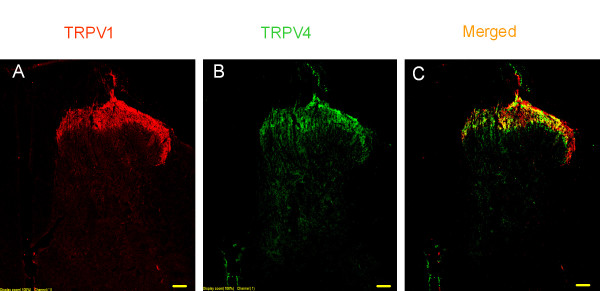
TRPV1 and TRPV4 are expressed at the central terminals and are co-localized in spinal dorsal horn. A. Immunostaining of TRPV1 in dorsal horn. B. Immunostaining of TRPV4 in dorsal horn. C. Merged image showing the extent of co-localization in yellow. Bar = 300 μm.